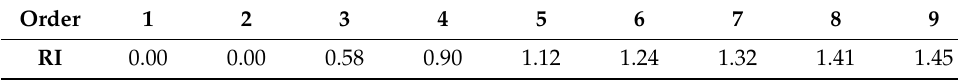
Table 4. Average randomness index.